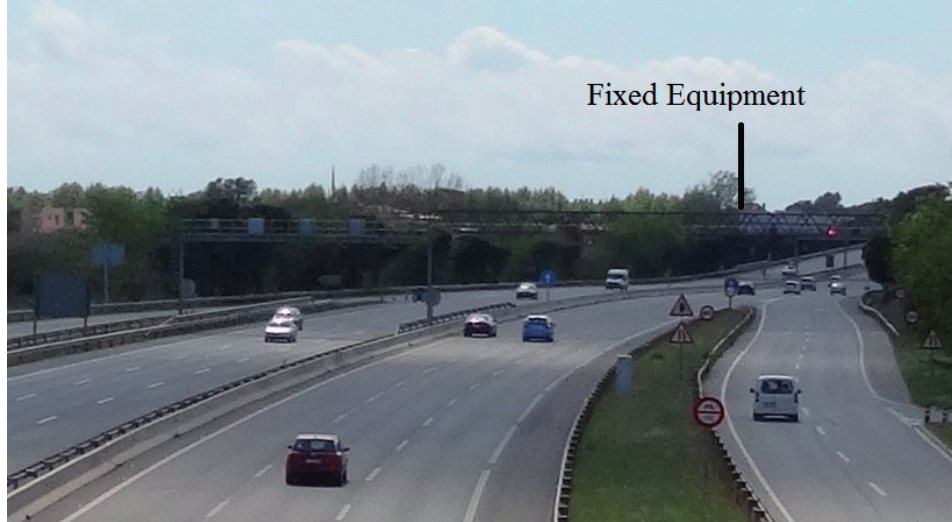
Figure 13. Deployment on a real